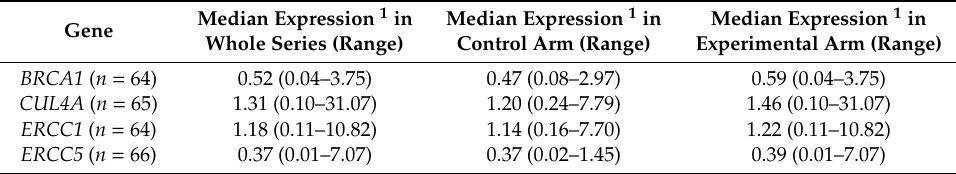
Table 2. Gene expression results.